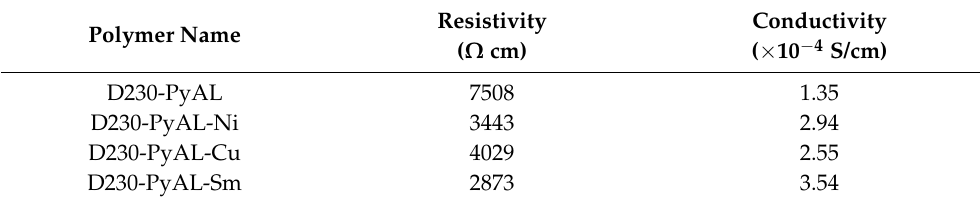
Figure 4. Resistivity and conductivity graphs for polymers and coordination polymers. Table 2. Resistivity and conductivity values for polymers and coordination polymers.